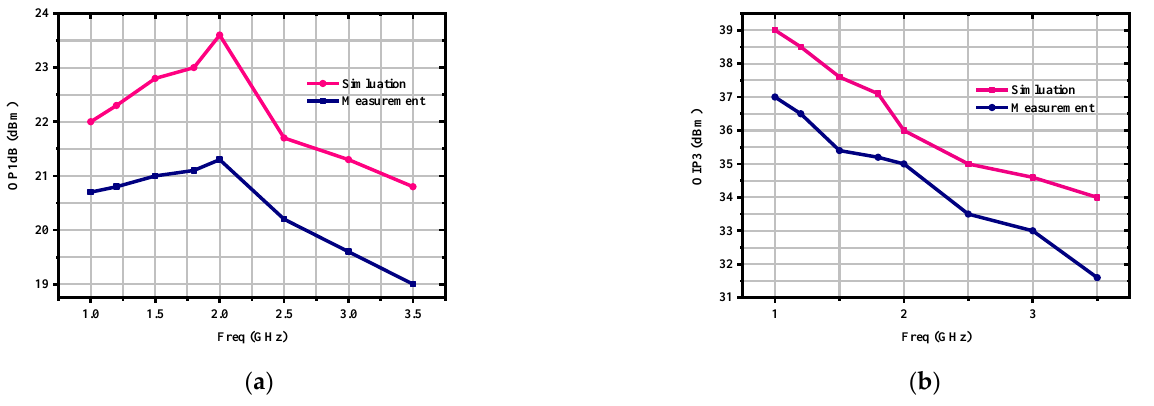
Figure 11. Linearity performance in the frequency range 1 GHz – 3.5 GHz ( a ) OP1dB; ( b ) OIP3. Table 2 present a comprehensive summary of the performance of the designed wide- band LNA and a comparison of the latest works of other published LNAs over the L to S-band. Table 2. Performance summary and comparison.